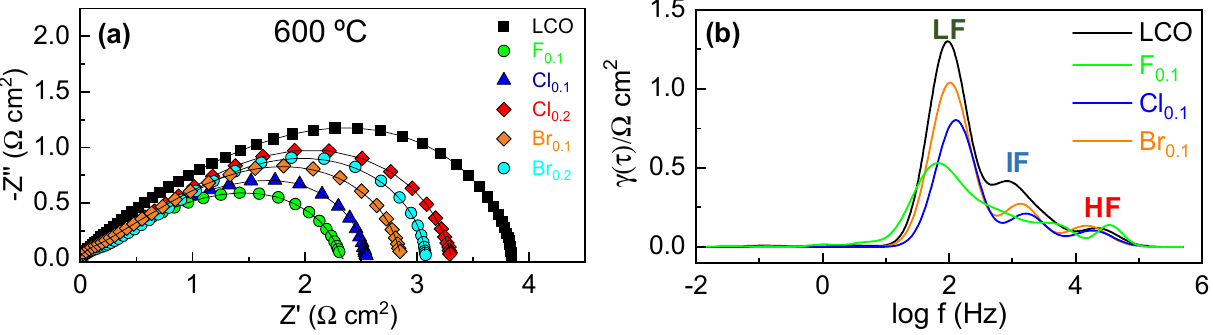
Figure 8. ( a ) Impedance spectra at 600 °C and the corresponding ( b ) distribution of relaxation times curves of La 2 CuO 4 − 0.5x A x (A = F, Cl, Br; x = 0, 0.1) series.